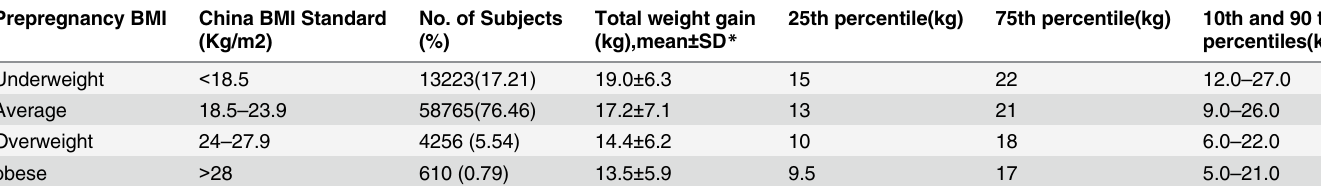
Table 1. Total maternal weight gain in Chinese women of different pre pregnancy BMI.